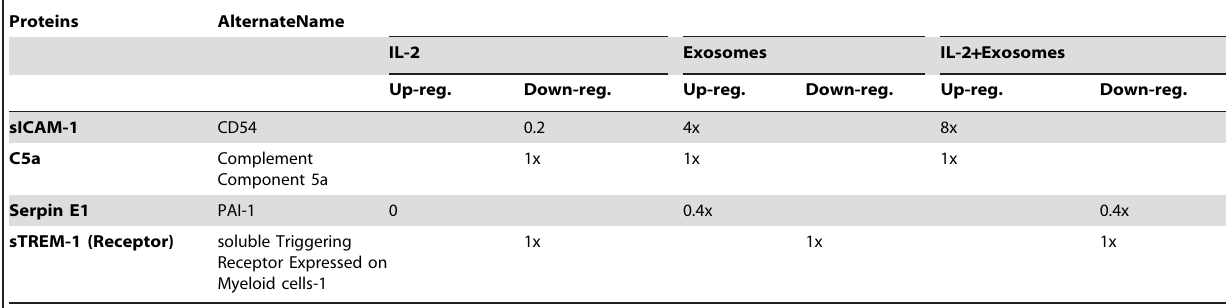
Table 3. Human cytokine array (Other